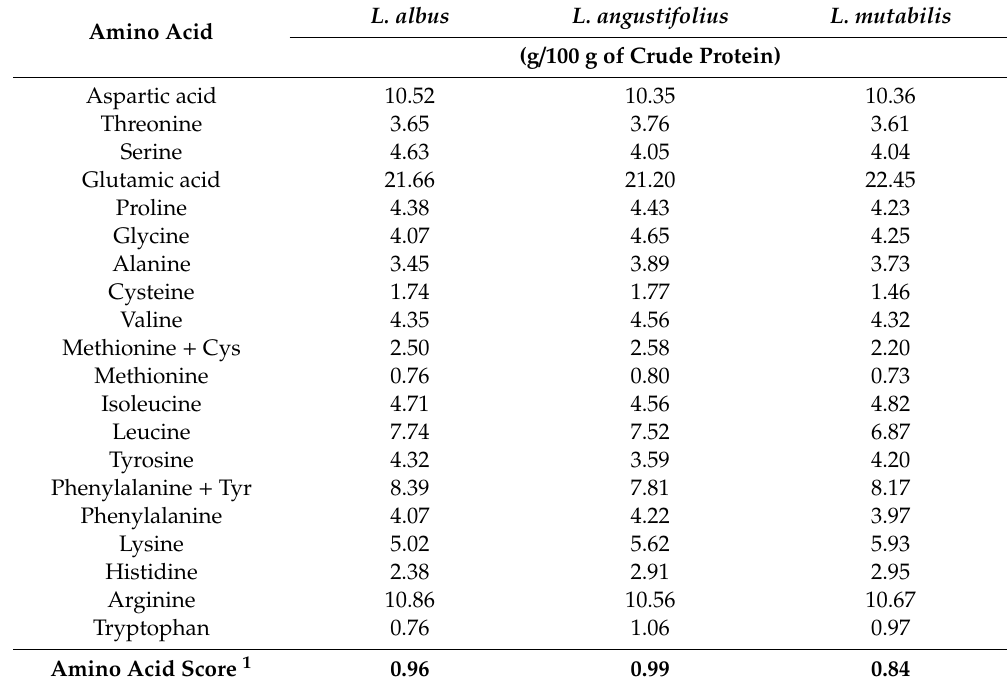
Table 3. Amino acid profile of lupin flours for three di ff erent varieties: albus , angustifolius, and mutabilis . Amino